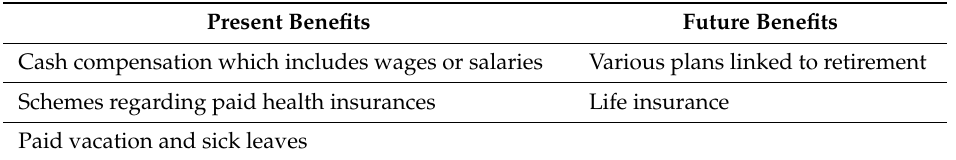
Table 1. Types of